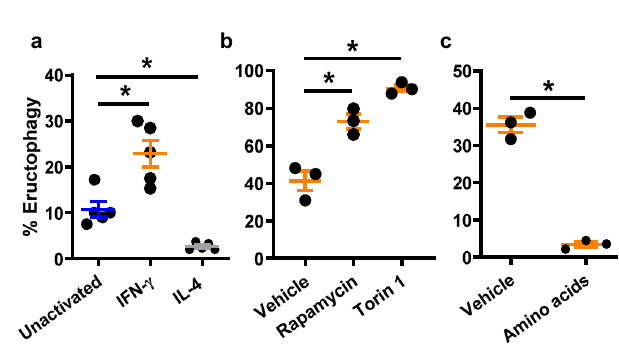
Fig. 4 Frequency of eructophagy is increased in IFN- γ -activated macrophages and further enhanced with mTOR inhibition.